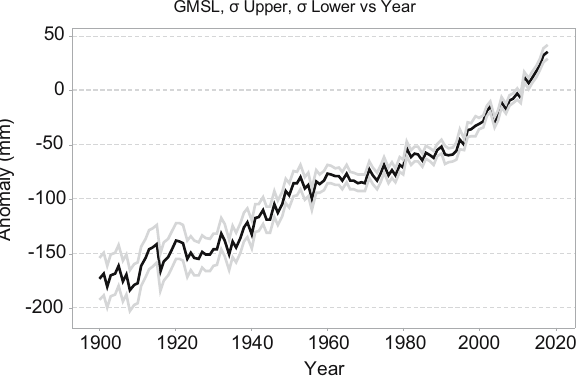
Figure 1: Yearly averaged anomalies of GMSL and their a priori uncertainties ( SE ) during 1900 – 2018 ( Frederikse et al. 2020 )